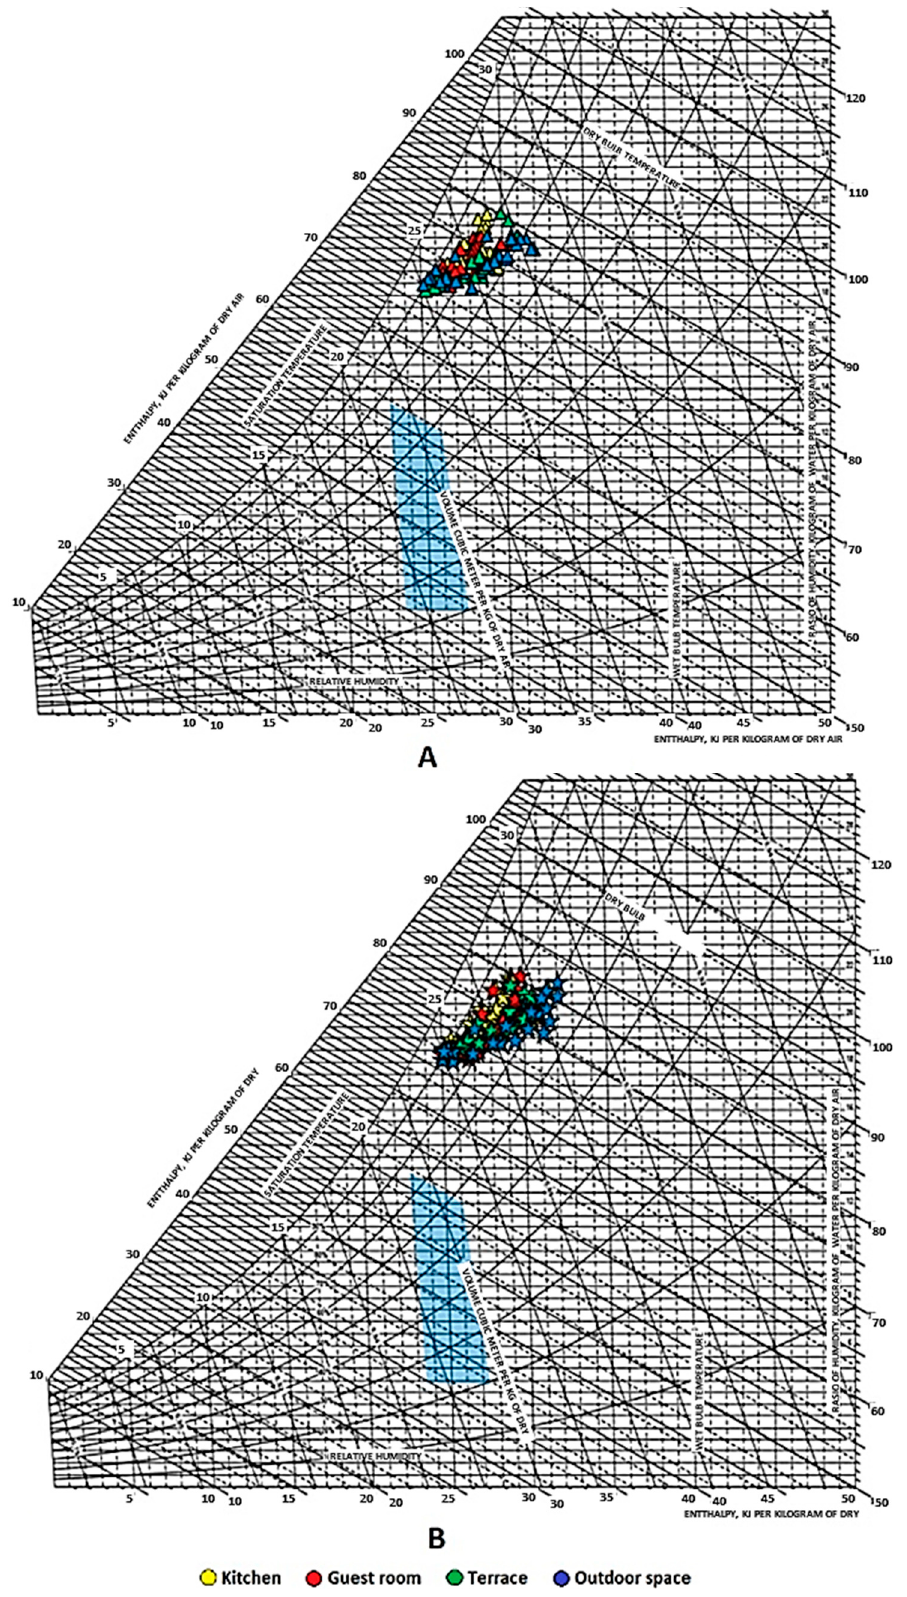
Figure 14. The psychrometric diagrams for exposed brick houses ( A ) and wooden houses on beaches, ( B ).